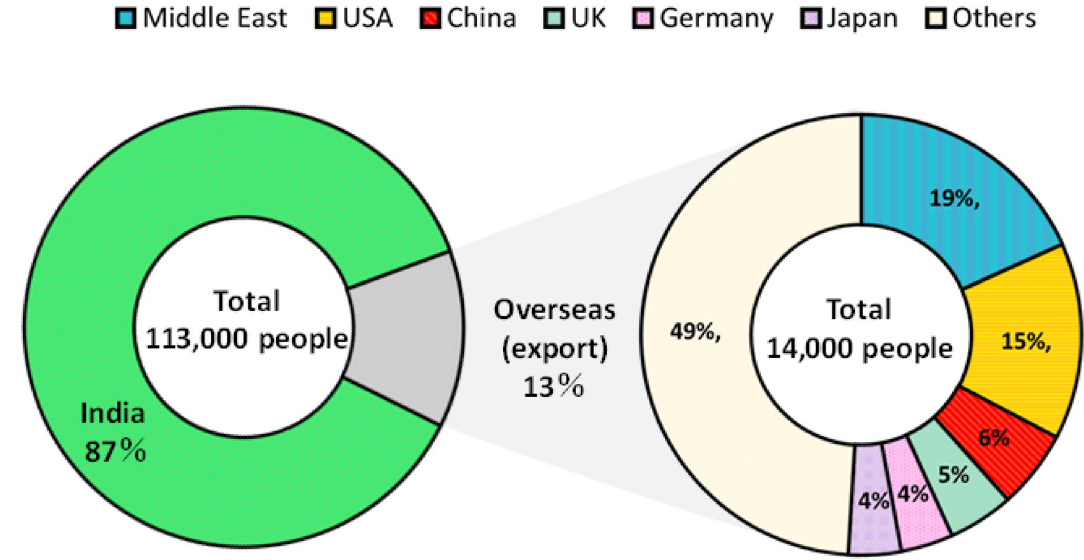
Figure 1. Consumption-based health impact in India triggered by domestic and international final demand.